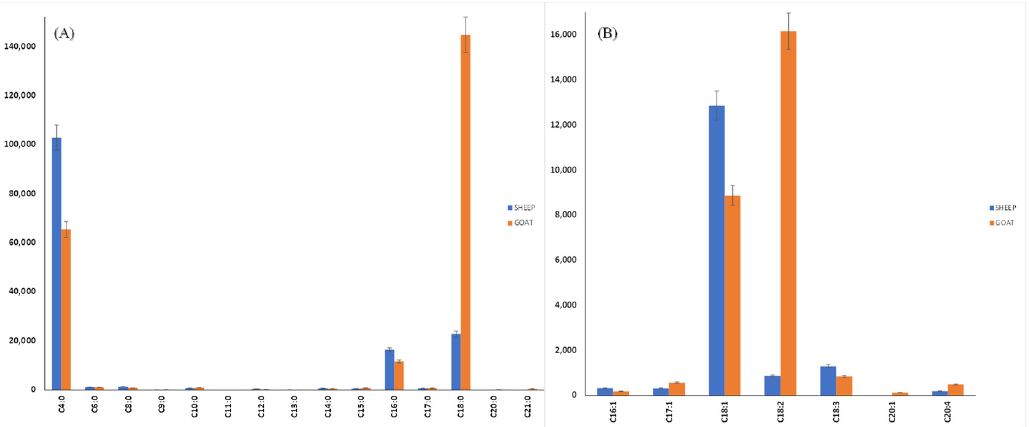
Figure 4. Triacylglycerols’ relative abundance of saturated ( A ) and unsaturated ( B ) fatty acids at the sn ‐ 1/3 positions.